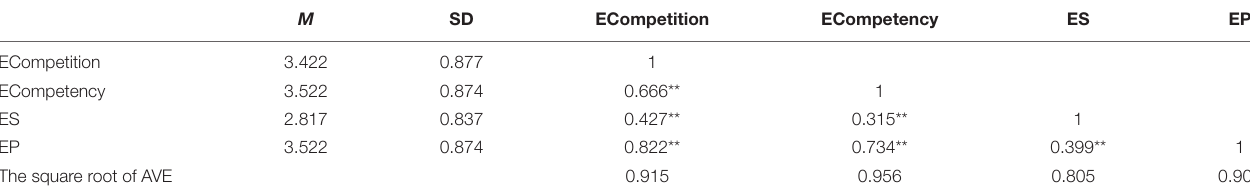
TABLE 3 | Descriptive and correlation analysis between